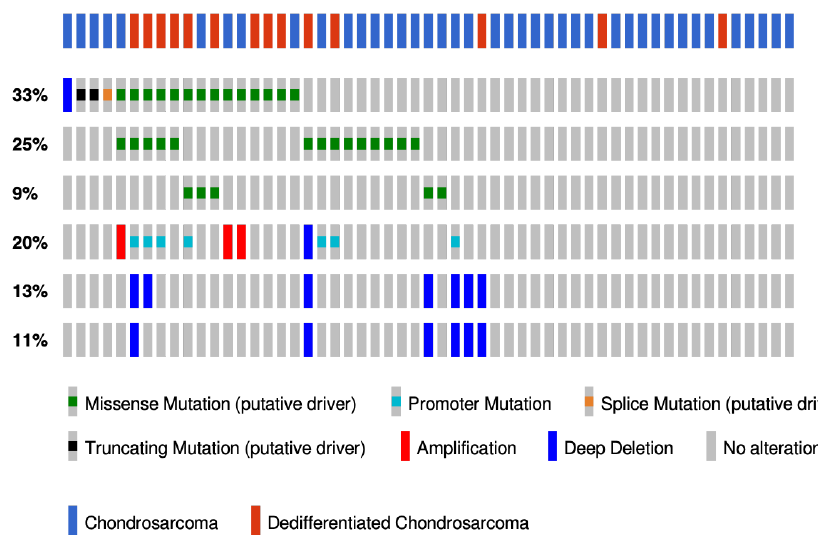
Figure 2. Oncoprint with the most frequently altered genes in conventional and dedifferentiated chondrosarcomas from MSKCC-IMPACT cohort. The oncoprint represents the most common alter- ations in 44 conventional and 14 dedifferentiated chondrosarcomas from the MSKCC impact cohort (taken from cbioportal website, https://www.cbioportal.org (accessed on 17 February 2022)).